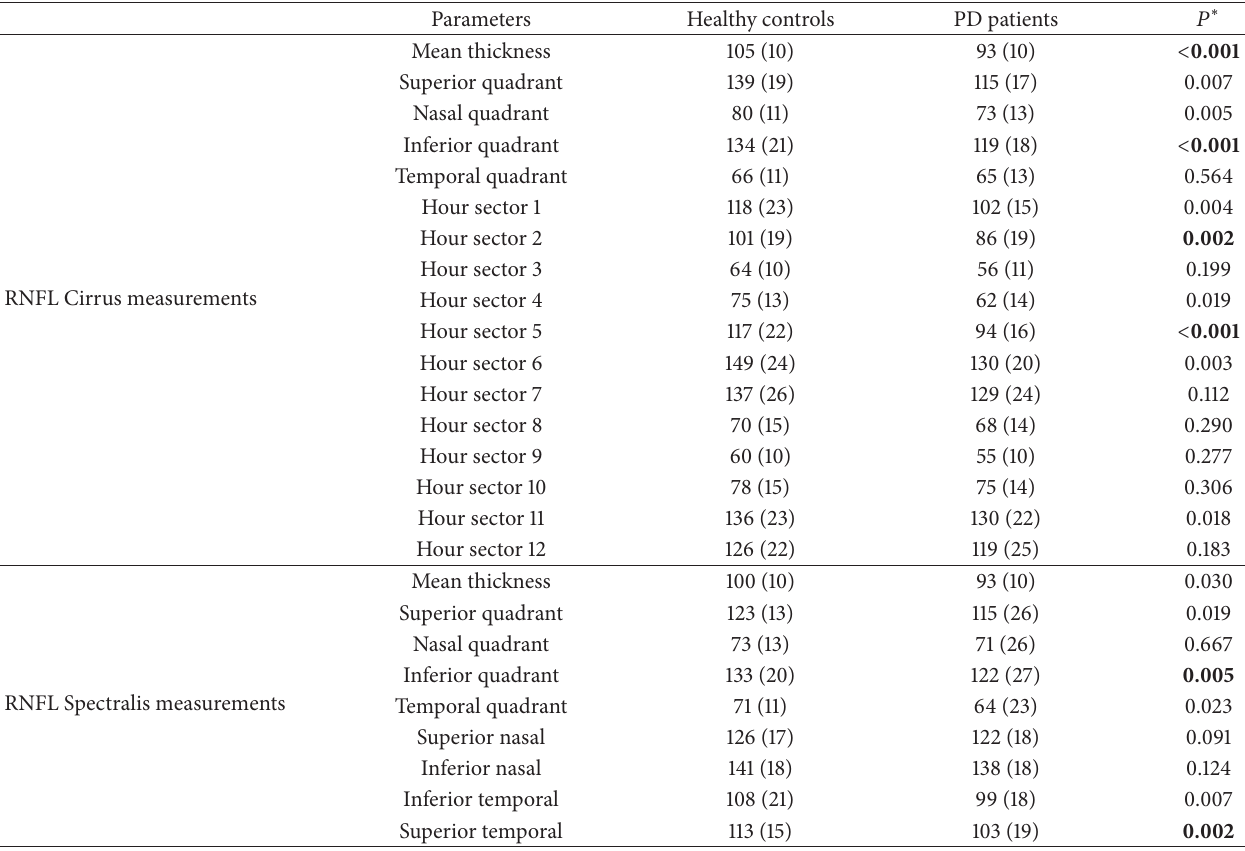
Table 3: Mean and standard deviation of retinal nerve fiber layer thicknesses obtained with the Cirrus and Spectralis optical coherence tomography devices in healthy controls and patients with Parkinson’s